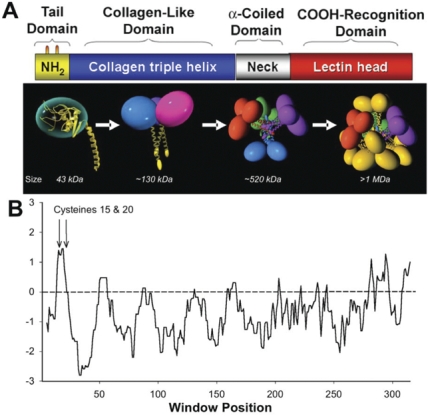
SP-D Structure(A) A model of SP-D structure. (Upper panel) The SP-D monomer (43 kDa) consists of a carbohydrate recognition domain which forms the globular head structure. This domain is connected to the collagen-like helical tail domain by a short, 30–amino acid, neck domain. At the end of the tail domain is the amino terminus in which cysteines 15 and 20 are positioned (shown as yellow projections). (Lower panel) Stylized representation of SP-D multimer assembly (note tail domains are shown shortened for ease of visualization). The head and neck domains drive the aggregation of the SP-D monomer to form a trimer of ∼130 kDa. These trimers associate to form a dodecamer (∼520 kDa). The forces holding this dodecamer together are unclear, although there is a dependency upon the amino-terminal cysteines as mutant lacking these cysteines do not form dodecamers. These dodecamers can assemble to a multimer of greater than 1 MDa. It is unclear whether the dodecamer is an essential intermediate in multimer formation. It should be noted that neither the trimer nor the dodecamer are globular proteins, due to the presence of the long collagen tail and thus under native conditions will behave as molecules with greater molecular radius.(B) Hydropathy plot of SP-D. A Kyle Doolittle hydropathy plot for the SP-D sequence was constructed using a window size of nine residues. A positive value indicates a region of hydrophobicity. The position of cysteines 15 and 20 are marked within the tail domain. As one can see, this is the most hydrophobic portion of the molecule.